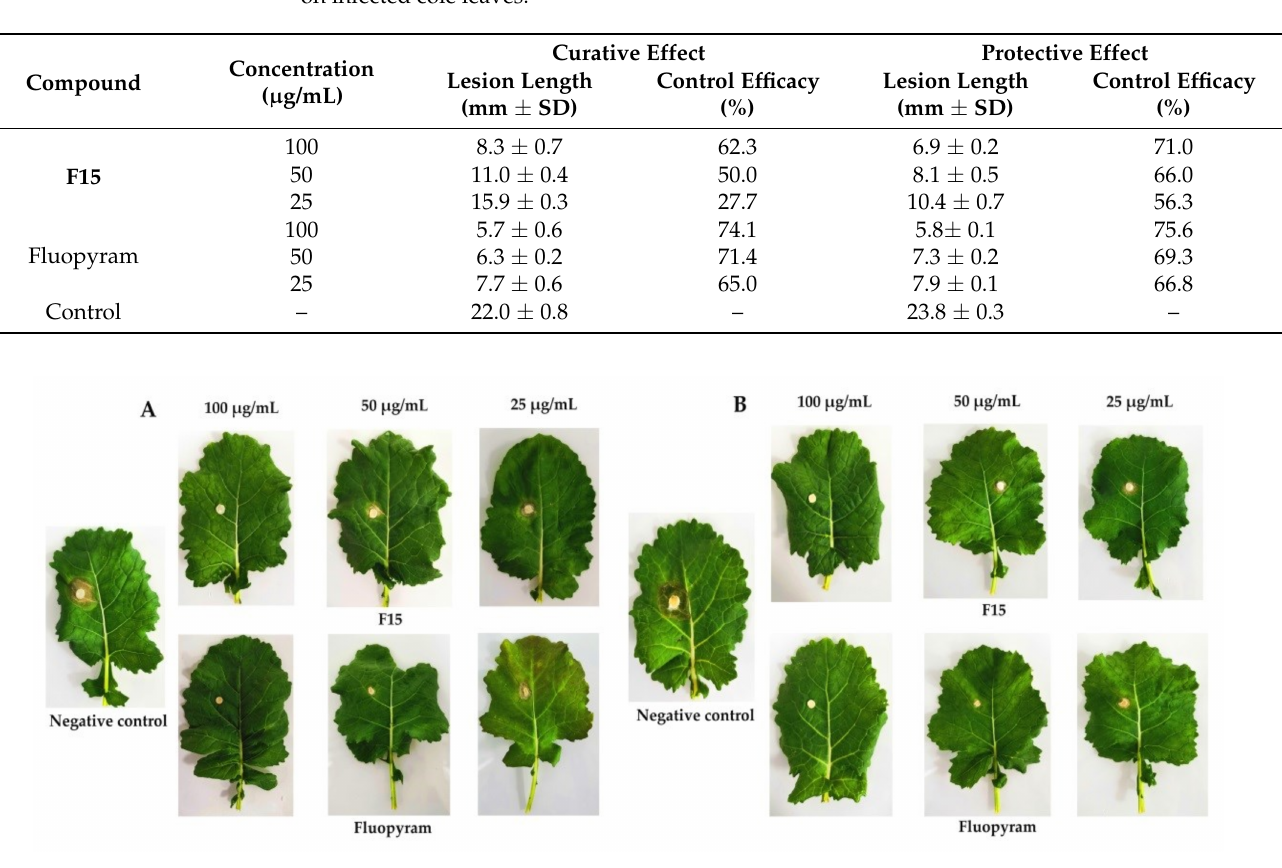
Figure 4. The curative effect ( A ) and protective effect ( B ) of F15 against S . sclerotiorum